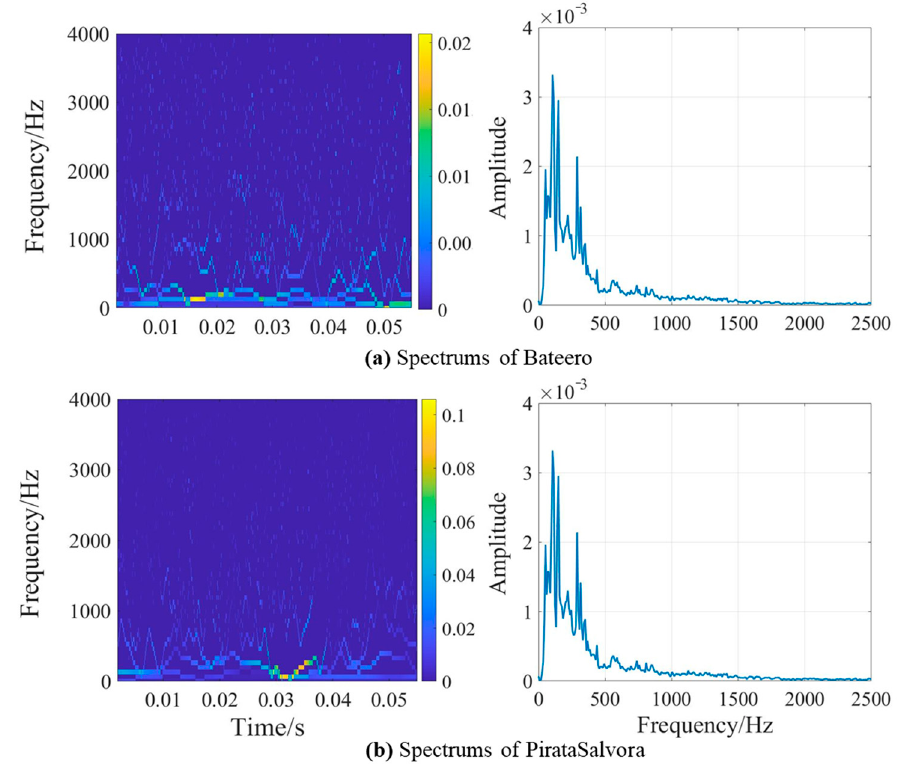
Figure 6. Hilbert-Huang spectrum and marginal spectrum: ( a ) Bateero, ( b ) PirataSalvora. Figure 6. Hilbert ‐ Huang spectrum and marginal spectrum: ( a ) Bateero, ( b ) PirataSalvora. Different ship-radiated noise, as well as different samples of the same Different ship ‐ radiated noise, as well as different samples of the same ship ‐ radiated